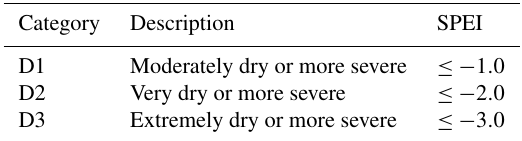
Table 2. Definition of the cases of Ref1, Ref2 and Ref3 based on the estimation and calibration periods for